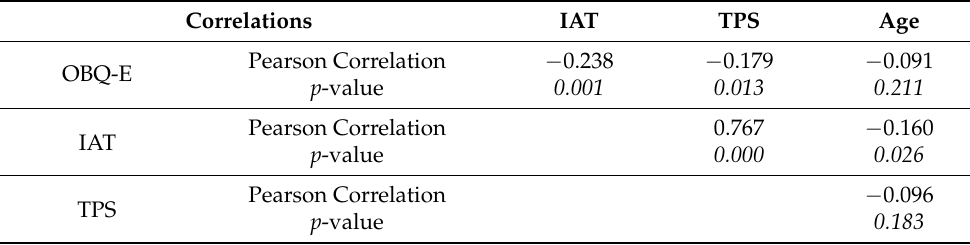
Table 6. Correlation of the instruments